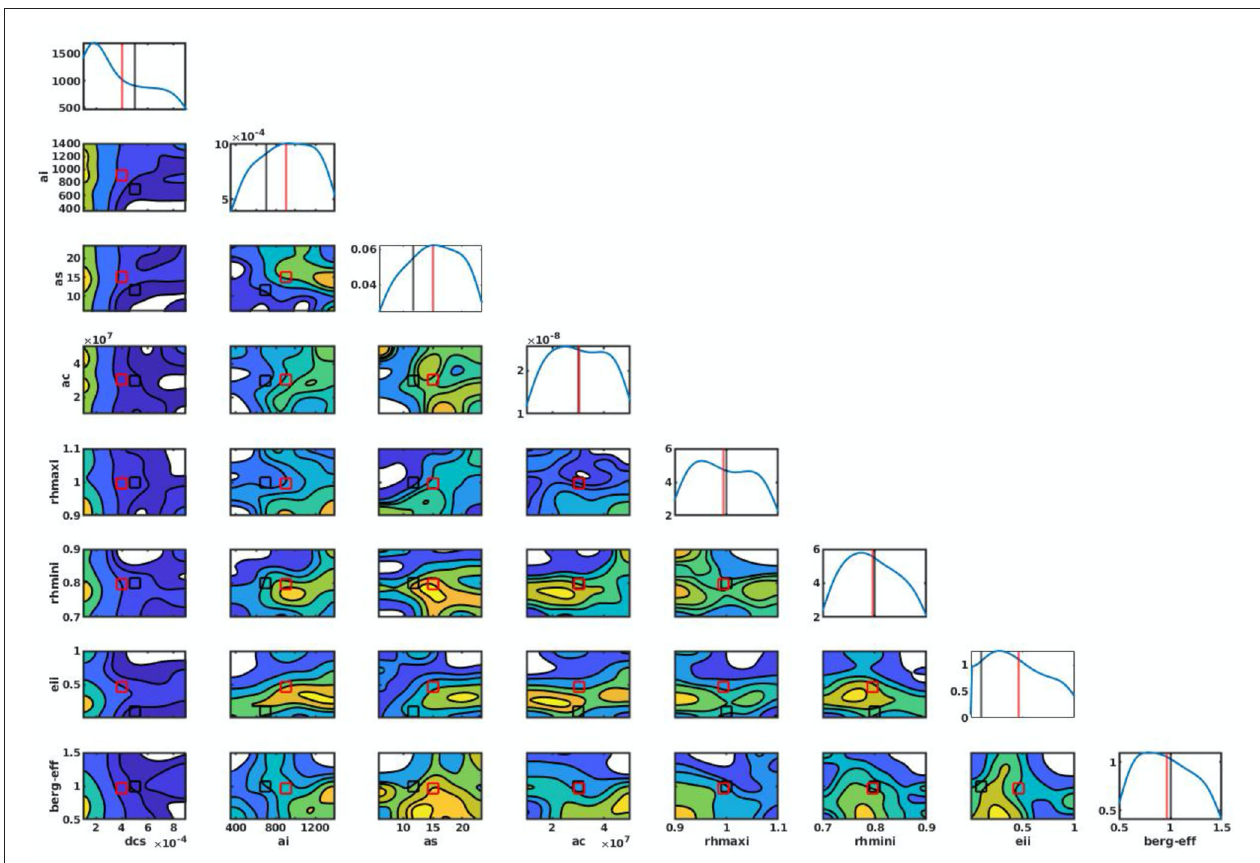
FIGURE 13 | Probability Distribution Functions (PDFs) of parameters using KDE along the diagonal of the matrix. The contour plots show the joint PDFs of two parameters. The black and red vertical lines show the default and posterior mean parameter